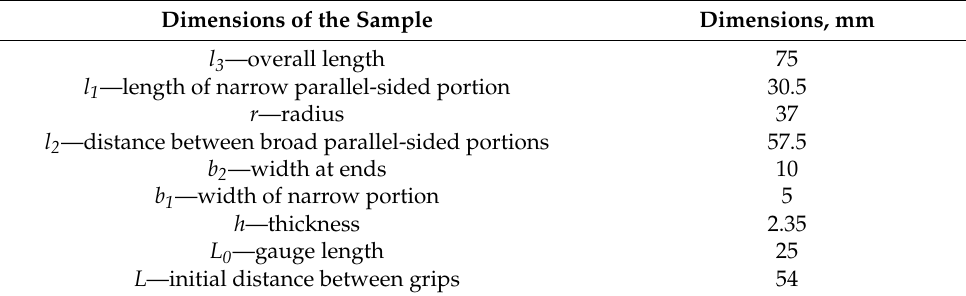
Figure 1. Sample type 1BA for strength test [41]. Table 2. Sample dimensions.